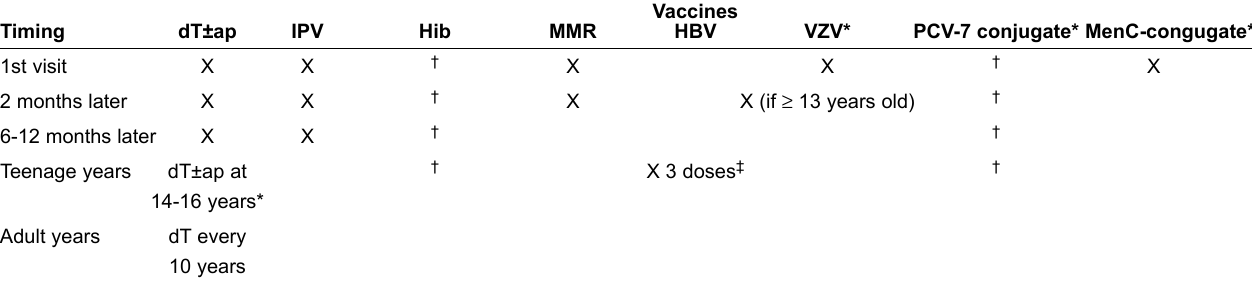
TABLE 3 Immunization schedule for children seven years of age and older not previously immunized in infancy (and still nonimmune)